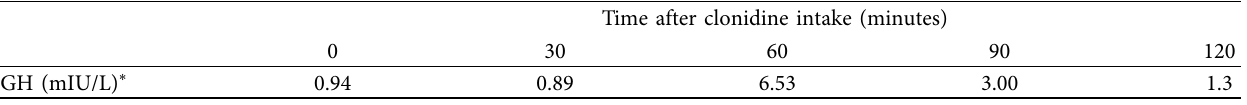
Table 2: Growth hormone stimulation test findings following clonidine intake.